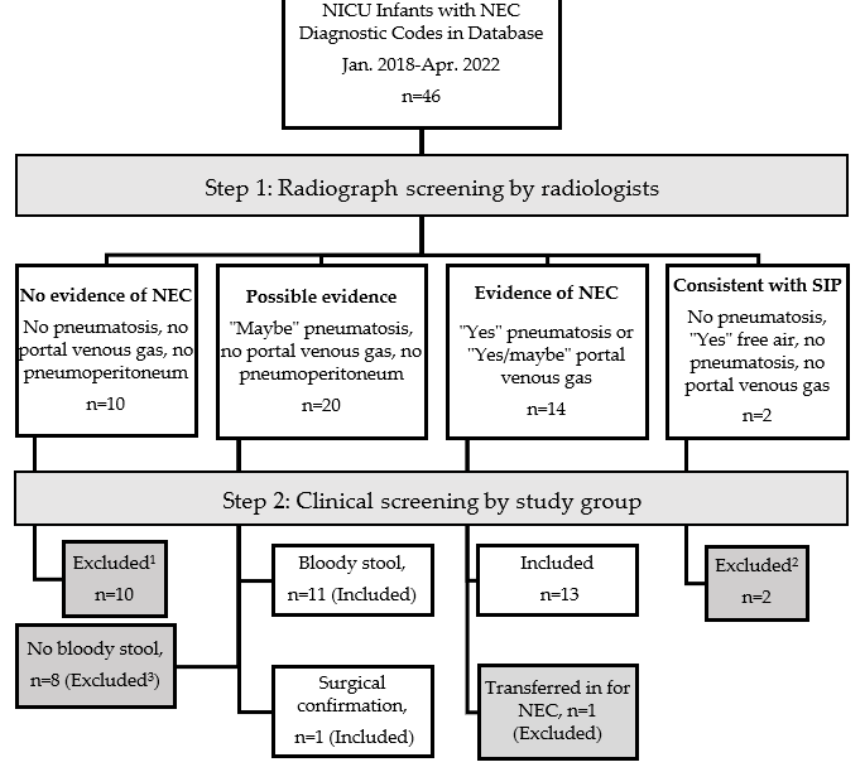
Figure 1. Flow diagram of necrotizing enterocolitis (NEC) selection from initial diagnoses code to end cohort included for analysis. EMR = electronic medical record, Dx = diagnosis, SIP = spontaneous intestinal perforation, 1 clinical course consistent with mild modified Bell Stage 1 or another non-NEC diagnosis, 2 SIP exclusion also considered relevant clinical factors (day of life, lack of feeds), 3 mild clinical courses without hemodynamic instability. Table 1. Demographics by severity of necrotizing enterocolitis